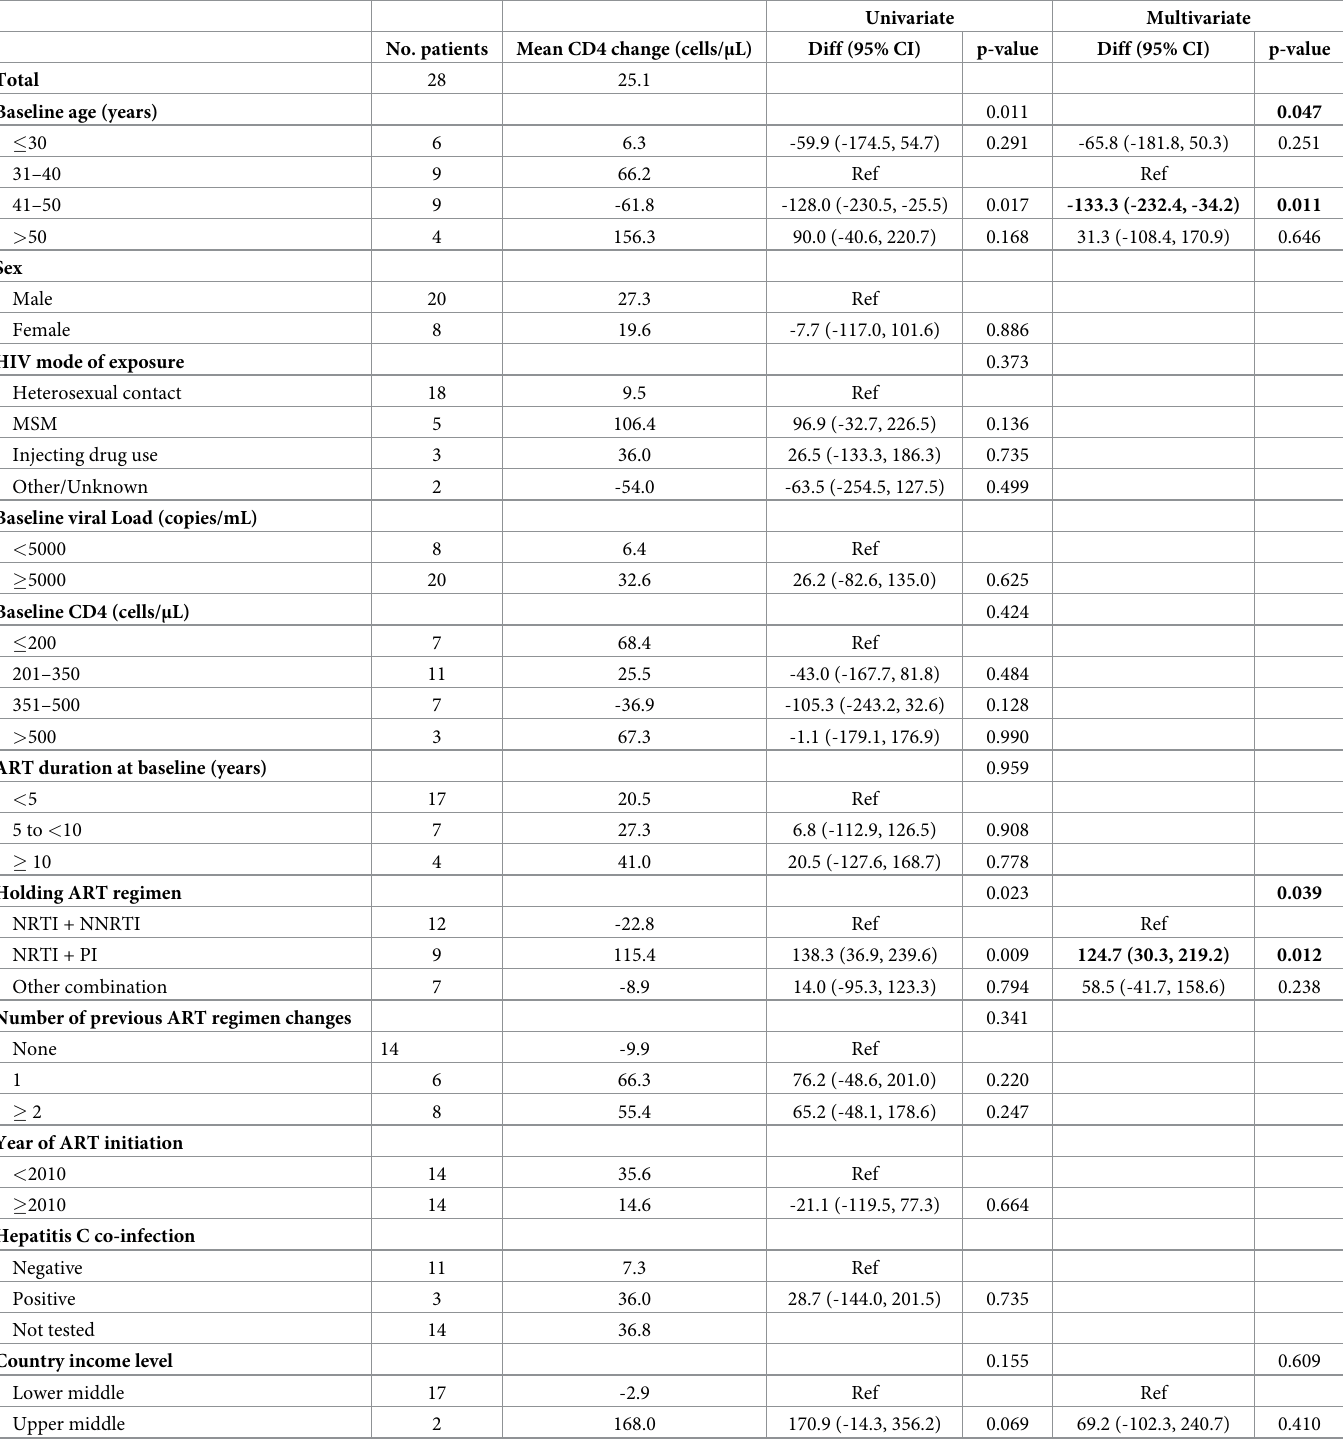
Table 4. Factors associated with CD4 cell count changes at 24 weeks from baseline in patients with holding